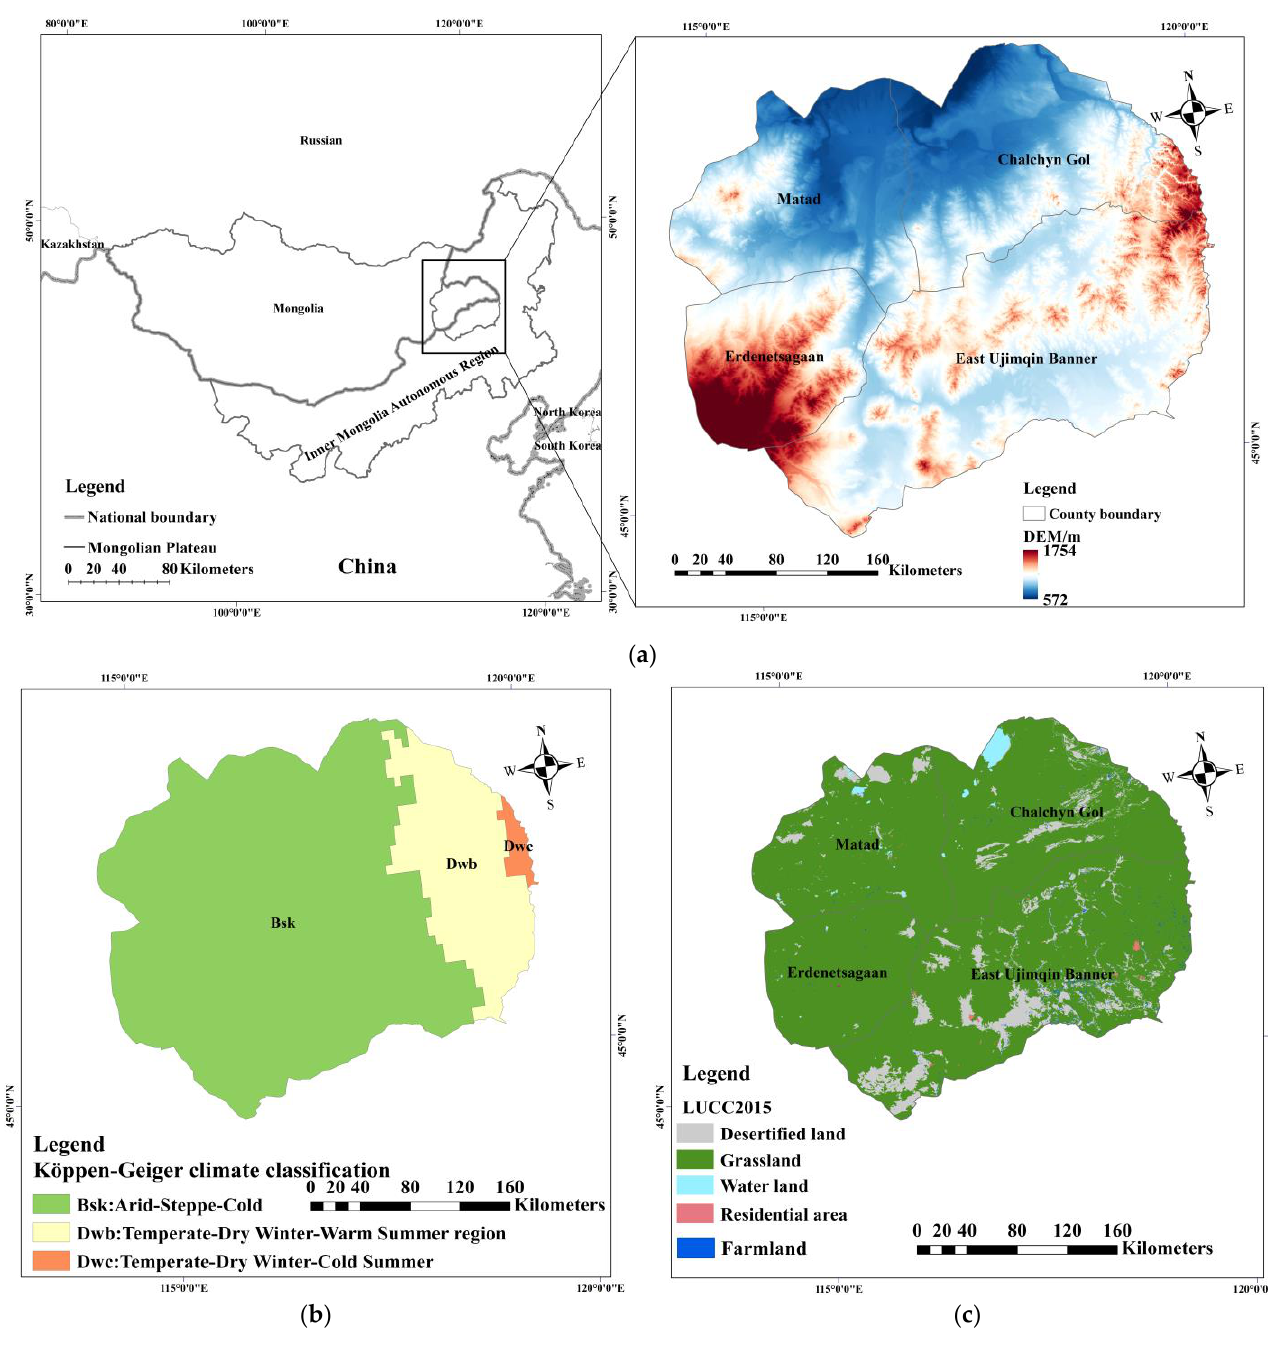
Figure 1. Overview of the study area. ( a ) Geographical location, administrative units and elevation; ( b ) Koppen–Geiger climate classification; ( c ) land use and land cover in 2015.